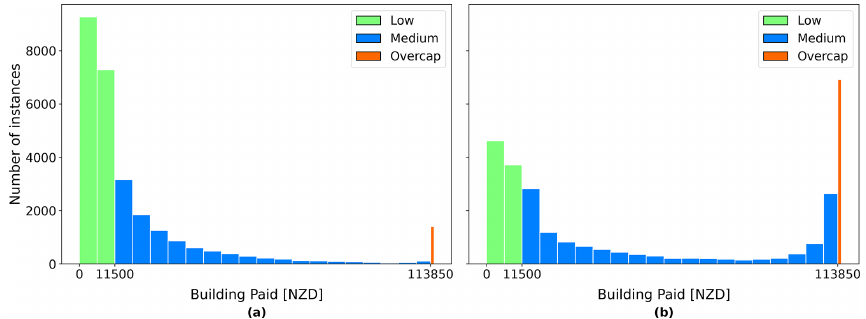
Figure 8. Distribution of BuildingPaid after selection of the instances between NZD0 and NZD115000: (a) 4 September 2010 and (b) 22 February 2011.